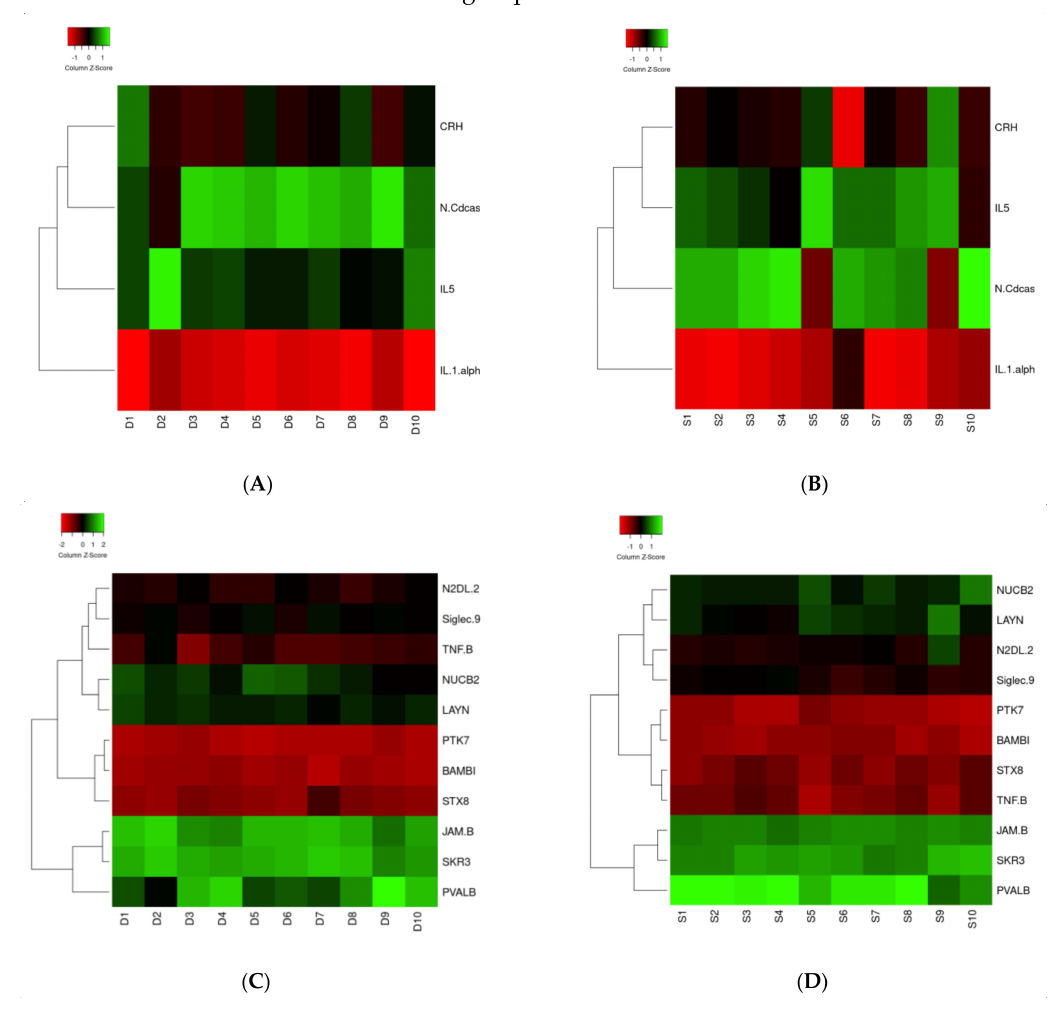
Figure 2. ( A – D ) Heat map of IL1A, ASAH2, IL5, and CRH (( A ): Surviving patients; ( B ): Non- surviving patients) and TNF-B, Siglec-9, LAYN, SKR3, JAM-B, N2DL-2, BAMBI, NUCB2, STX8, PTK7, and PVALB (( C ): Surviving patients; ( D ): Non-surviving patients) proteins in correlation with the survival and dead groups. The 11 proteins in the middle were found in the present study. Circulated proteins were identified as linked to the proteins of the present study, which is shown by the red lines. From WebGestalt, all four proteins with >2/< − 0.5-fold changes were shown to be involved in metabolic processes, response to stimuli, and cell communication (biological process category) (Figure 3). Three proteins were involved in extracellular space (cellular component category) and protein binding (molecular function category). The GeneMania software was utilized to examine the network and correlating proteins for each